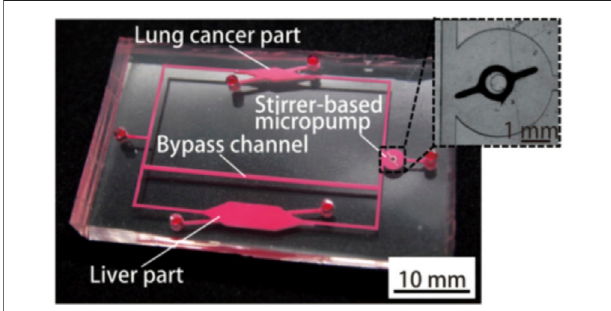
FIGURE 8 | Photograph of the fabricated organs-on-chips with a liver part,alungcancerpart,andotherpartsconnectedbymicro-channels(Shinha et al.,